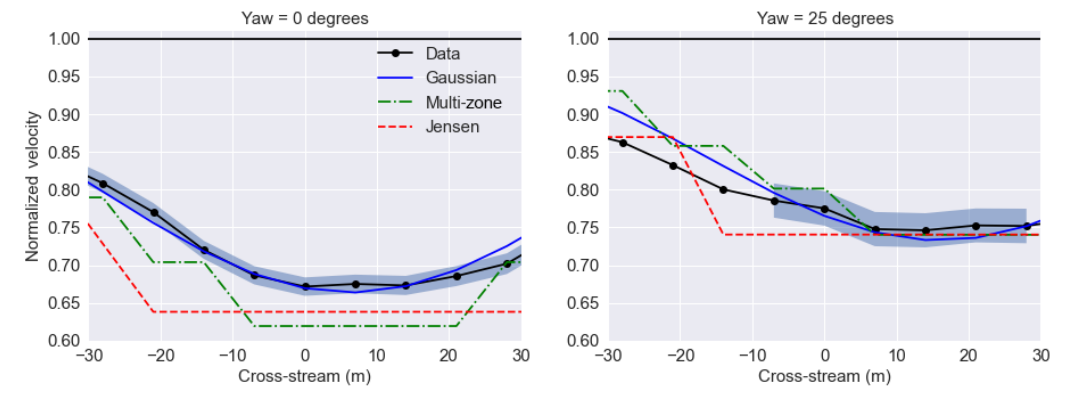
Figure 6. Velocity deficit at 180.95m downstream computed using lidar data, the Gaussian wake model, the multi-zone wake model, and the Jensen wake model under different yaw misalignment